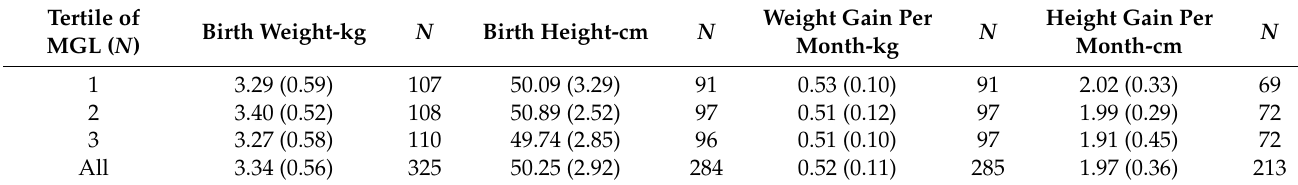
Table 1. Offspring weight and height statistics.